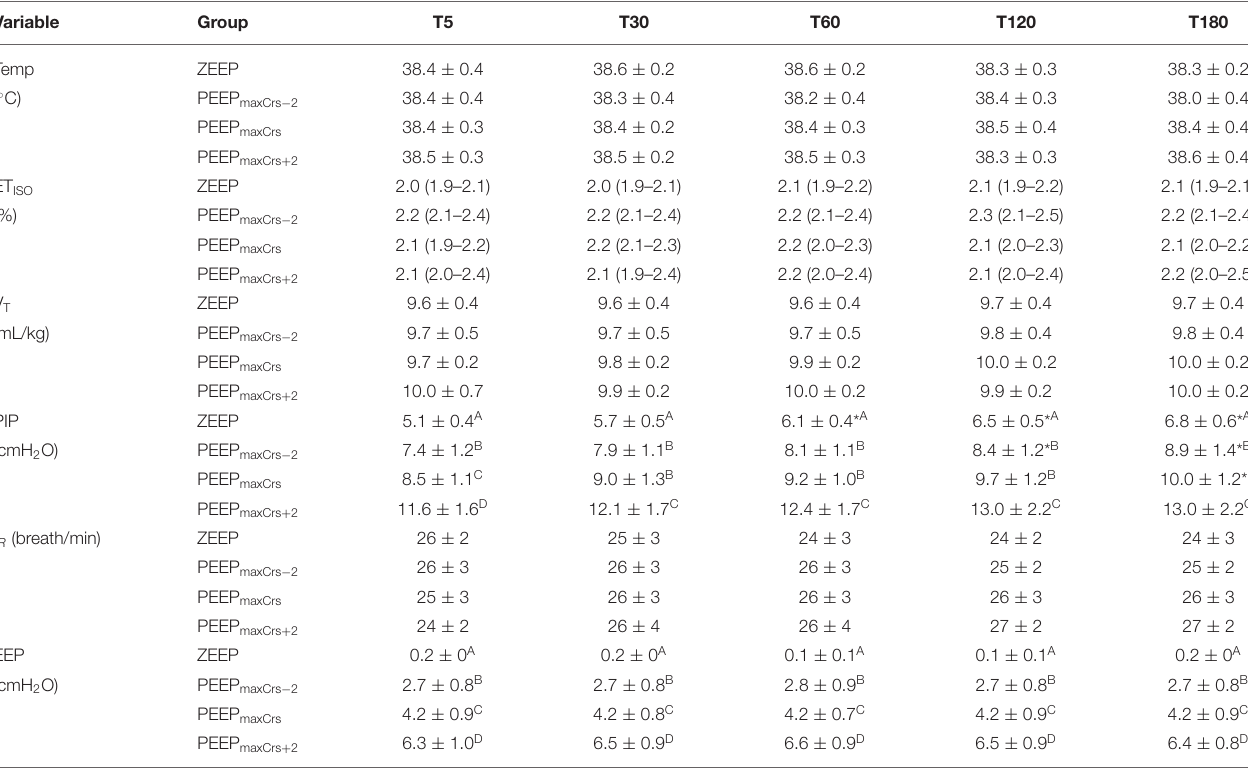
TABLE 2 | Temperature, end-tidal isoflurane concentration, and ventilator variables in six isoflurane-anesthetized cats mechanically ventilated for 3h with a tidal volume of 10 ml/kg and four end-expiratory pressure (EEP) treatments: zero end-expiratory pressure (ZEEP), positive end-expiratory pressure (PEEP) of highest respiratory